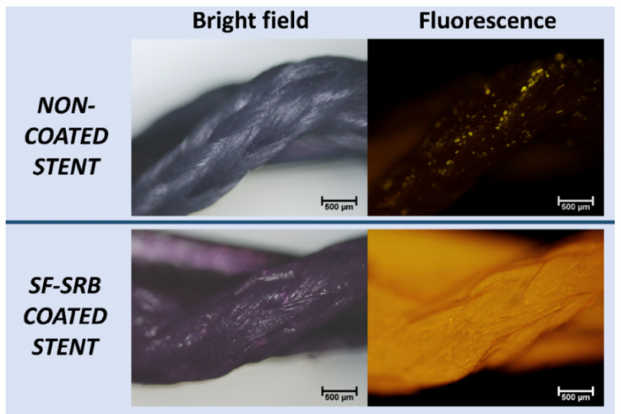
Figure 7. Assessment of SF coating with SRB fluorescent dye. Comparative study between BraidStent-2 (non-coated stent) and BraidStent-SF with SRB coating. Fluorescence microscopy showed adequate homogeneity of SF